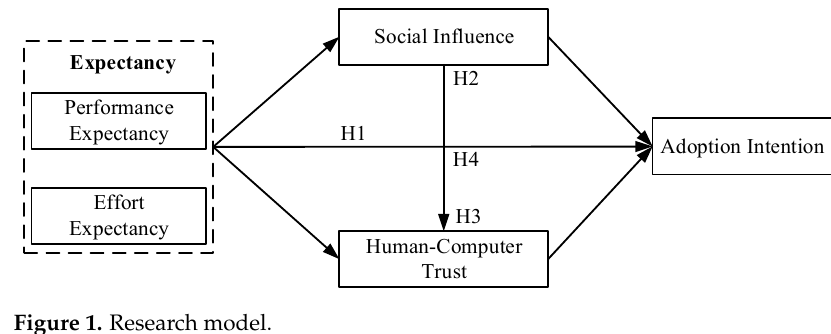
Figure 1. Research